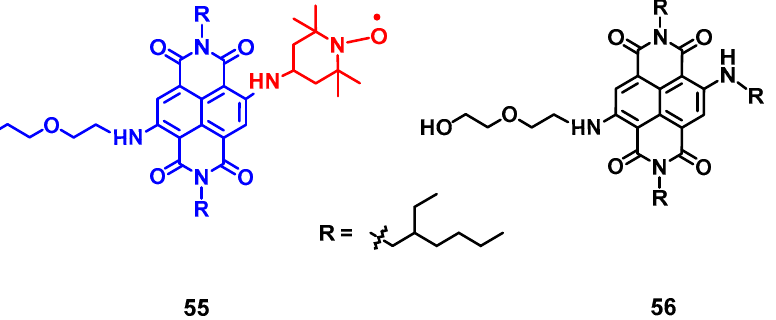
Figure 18. NDI-TEMPO dyad 55 as red light-absorbing triplet PS and the reference compound 56 .